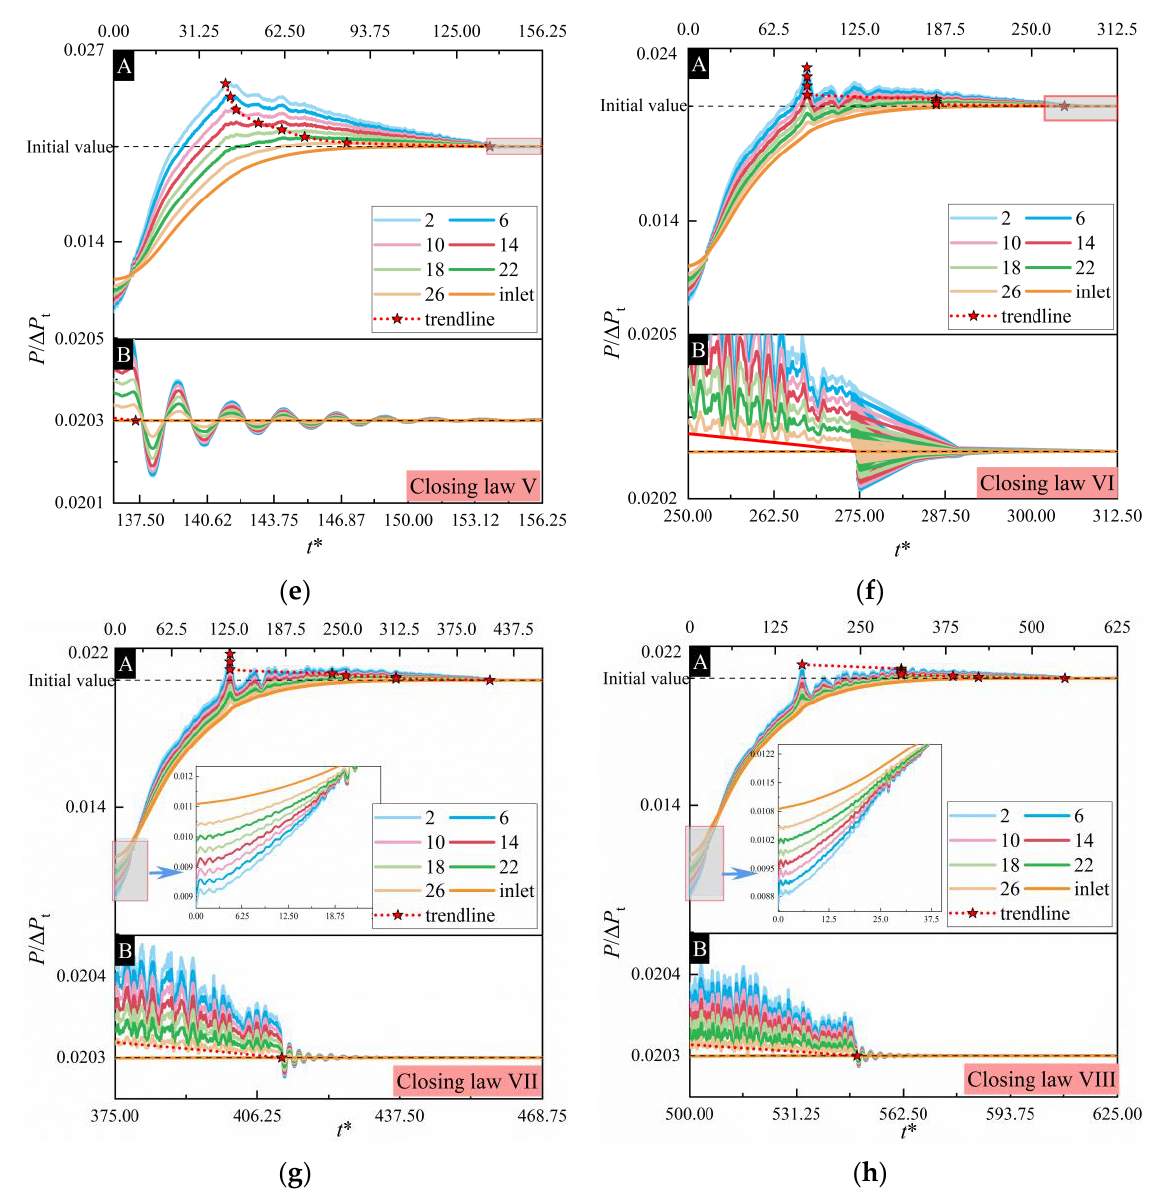
Figure 8. Variation curve of water hammer pressure with valve closing times: ( a ) t * = 31.25 ( b ) t * = 62.5 ( c ) t * = 97.35 ( d ) t * = 125 ( e ) t * = 156.25 ( f ) t * = 312.5 ( g ) t * = 468.75 ( h ) t * = 625.